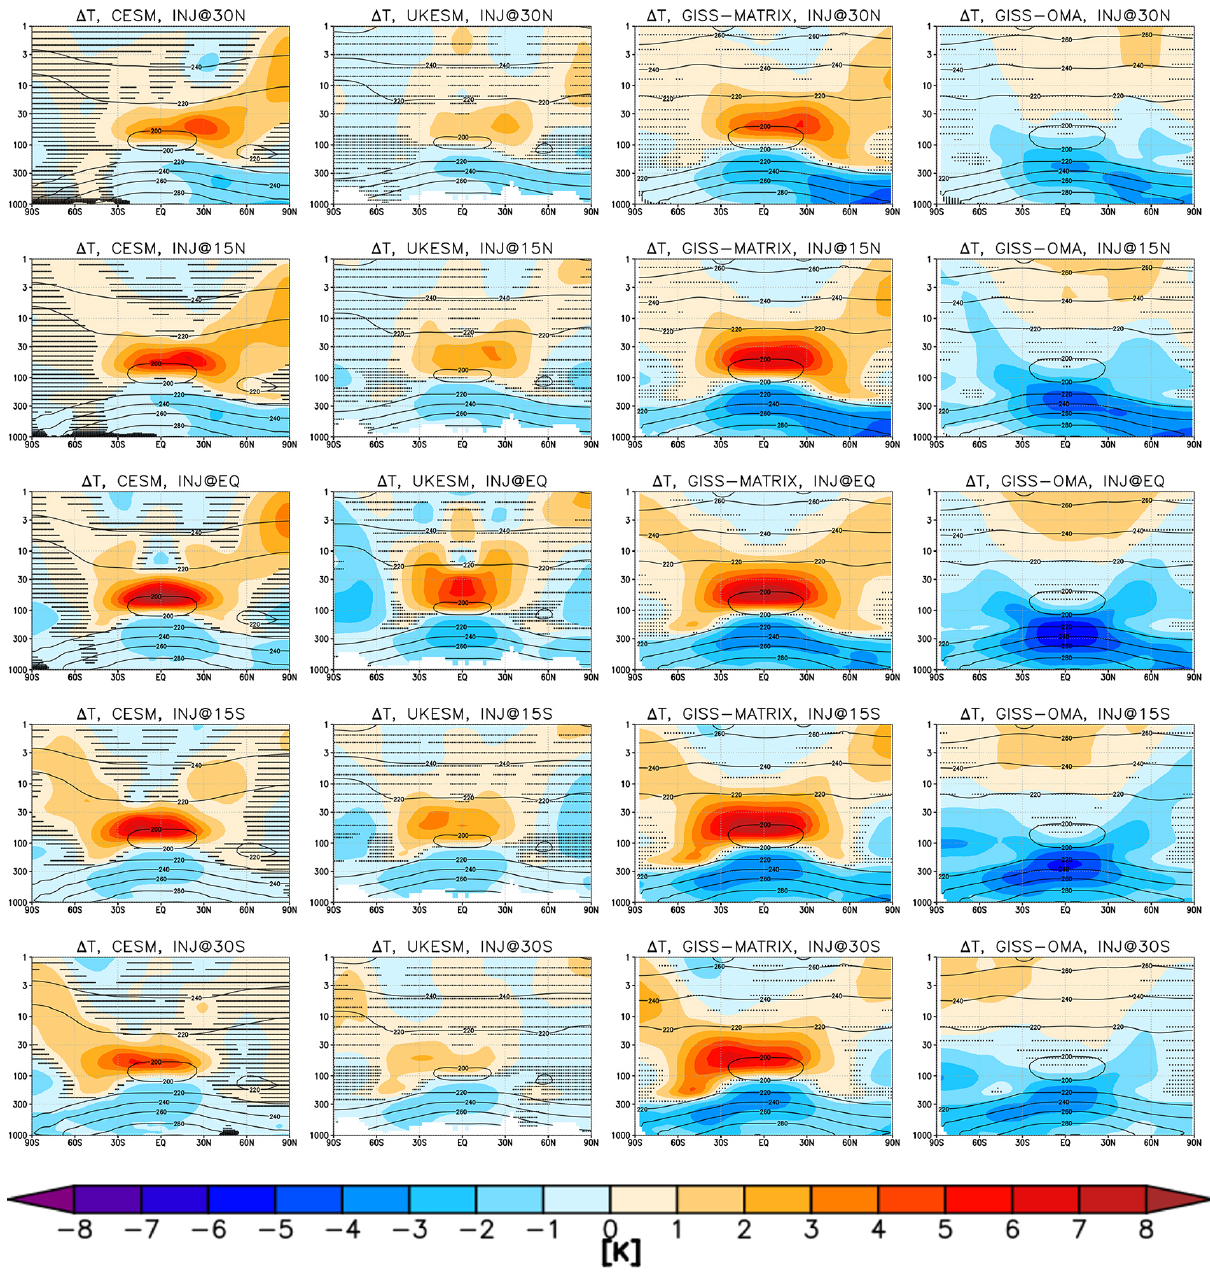
Figure 5. Shading: yearly mean changes in temperature [K] averaged over the last 8 years of the simulations compared to the same period in the SSP2–4.5 run for CESM (column 1), UKESM (column 2), GISS-MATRIX (column 3), and GISS-OMA (column 4). Contours show the values in the control SSP2–4.5 run for reference. Stippling as in Fig.